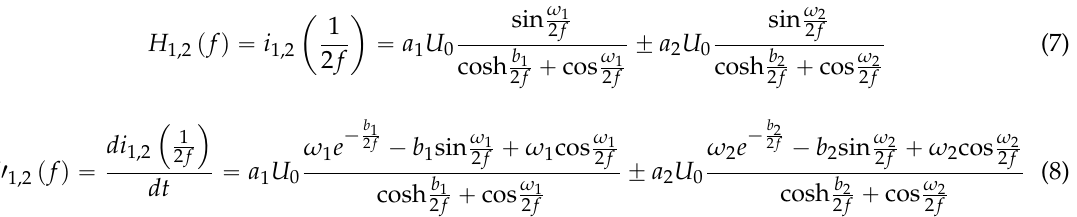
Figure 5. Hamel loci when C 2 increases: ( a ) feedback variable i 1 ; and ( b ) feedback variable i 2 with an integrator. 3. Automatic Delay Compensation in Self ‐ Oscillating WPT System The frequency characteristics and delay compensation of the self ‐ oscillating WPT system with the delay